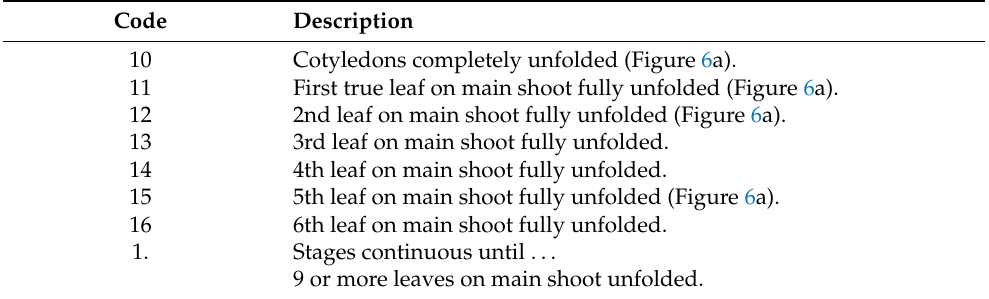
Table 2. Description of principal stage 1 (leaf development) of slender nightshade, based on the BBCH scale.